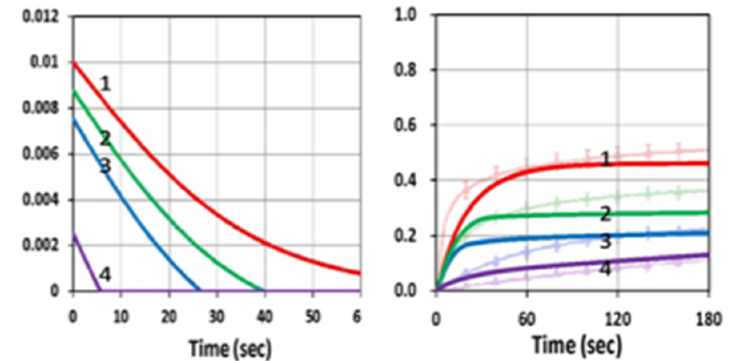
Figure 8. The initiation radical (left) and conversion (right) profiles for C 20 = (0, 0.5,1.0, 3.0), for curve (red, green, blue, violet), in the presence of both blue and UV light; for b 1 = 0.04, b 2 = 0.002, b 3 = 0.1 (1/s/%), k’ = 2.0 (1/s), k 48 =10 (1/s), k 37 = 20(1/s) and k 57 = 0.01 (1/s). In right figure, the background is measured data from van der Laan et al. [11].